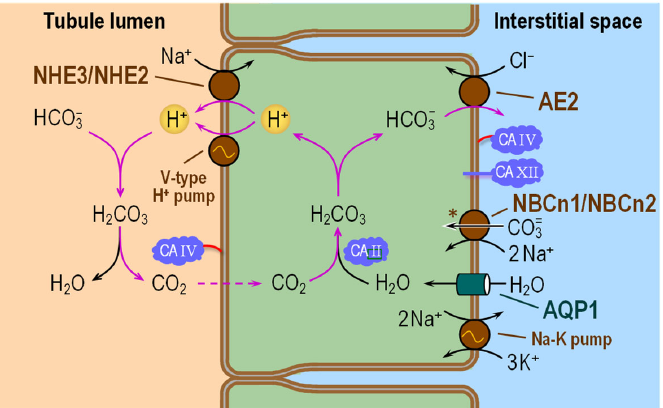
Figure 7. Cell model of HCO 3 − reabsorption in the thick ascending limb. In the lumen, filtered HCO 3 − and H + —secreted by NHE3/NHE2 and V-type H + pump—react to form CO 2 and H 2 O under the catalytic action of CA IV. Apical entry of CO 2 and basolateral entry of H 2 O via AQP1 lead to the intracellular formation of HCO 3 − and H + under the catalytic action of CA II. AE2 carries HCO 3 − out of the cell across the basolateral membrane. The brown symbol ‘*’ near NBCn1/NBCn2 denotes uncertainty about NBCn1/NBCn2 stoichiometry. For details, see text. NHE3/NHE2 = Na-H exchanger 3/Na-H exchanger 2; V-type H + pump = Vacuolar-type H + pump (or V-ATPase); CA II, CA IV and CA XII = carbonic anhydrase II, IV and XII; AE2 = anion exchanger 2; AQP1 = aquaporin 1; NBCn1/NBCn2 = electroneutral Na/HCO 3 cotransporter 1/electroneutral Na/HCO 3 cotransporter 2.